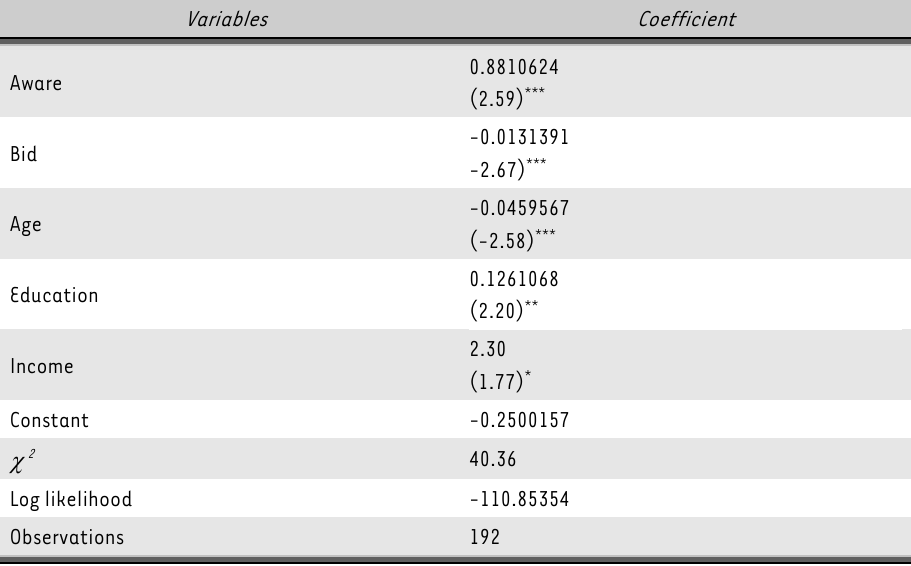
Coefficient estimates for the multivariate logit model– a reduced model